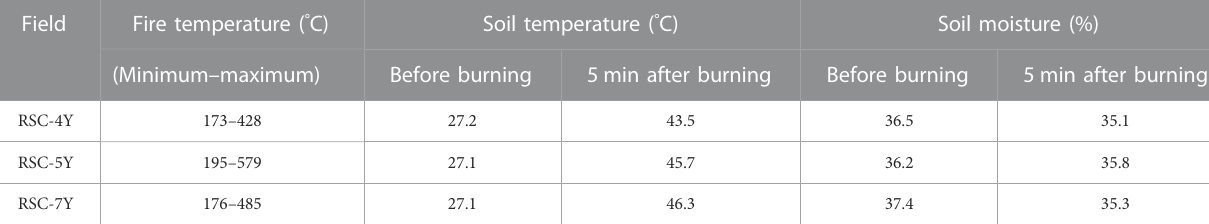
TABLE 1 Fire temperature, soil temperature, and soil moisture after burning of RSC fi elds.